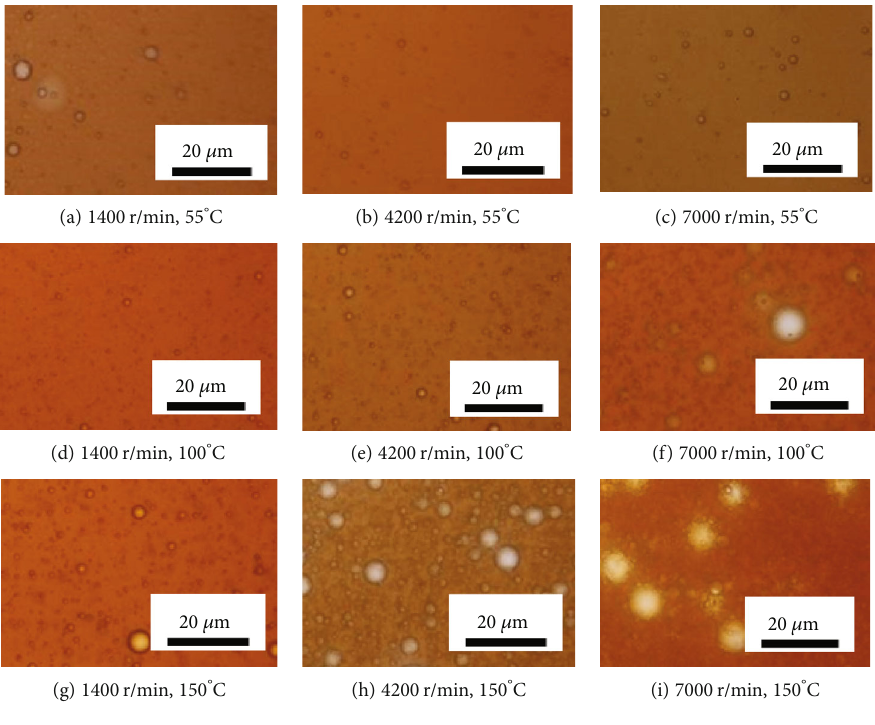
Figure 3: Microscope images of heavy oil emulsions at di ff erent temperatures and di ff erent stirring rates.